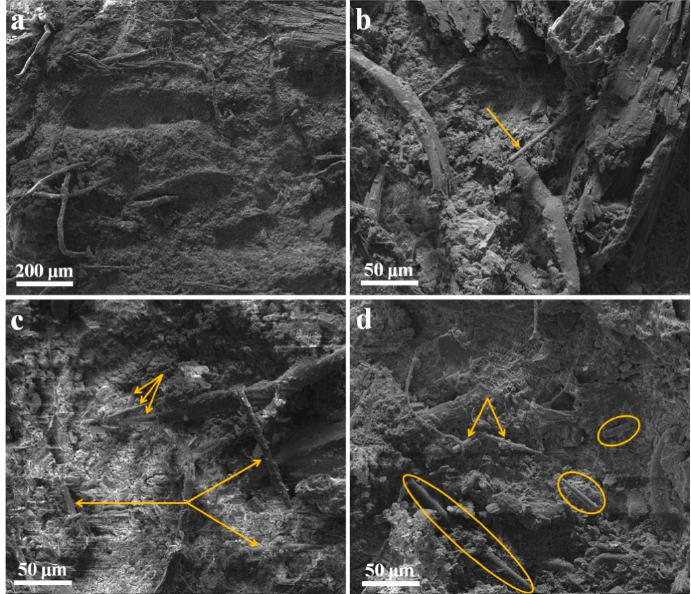
Figure 4. SEM images of the fracture surface of the friction composites: ( a ) Bas-0; ( b ) Bas-5; ( c ) Bas-15; and ( d ) Bas-25. Arrows indicate the reinforcing fibers, and ellipses indicate the broken fibers.